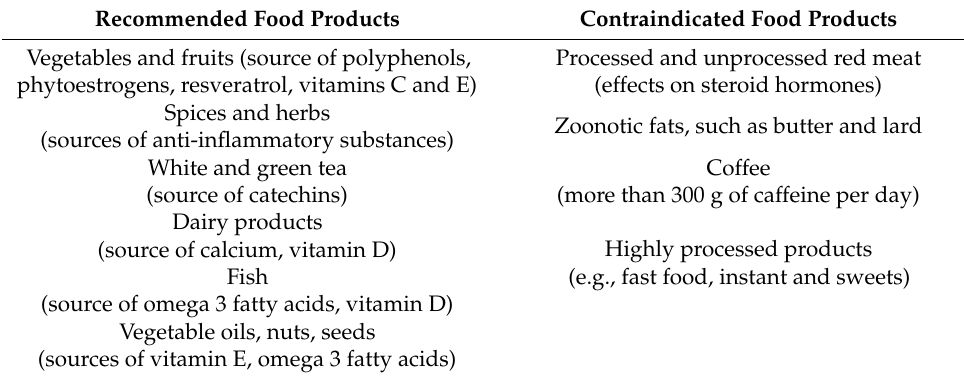
Table 1. Recommended and contraindicated foods in endometriosis